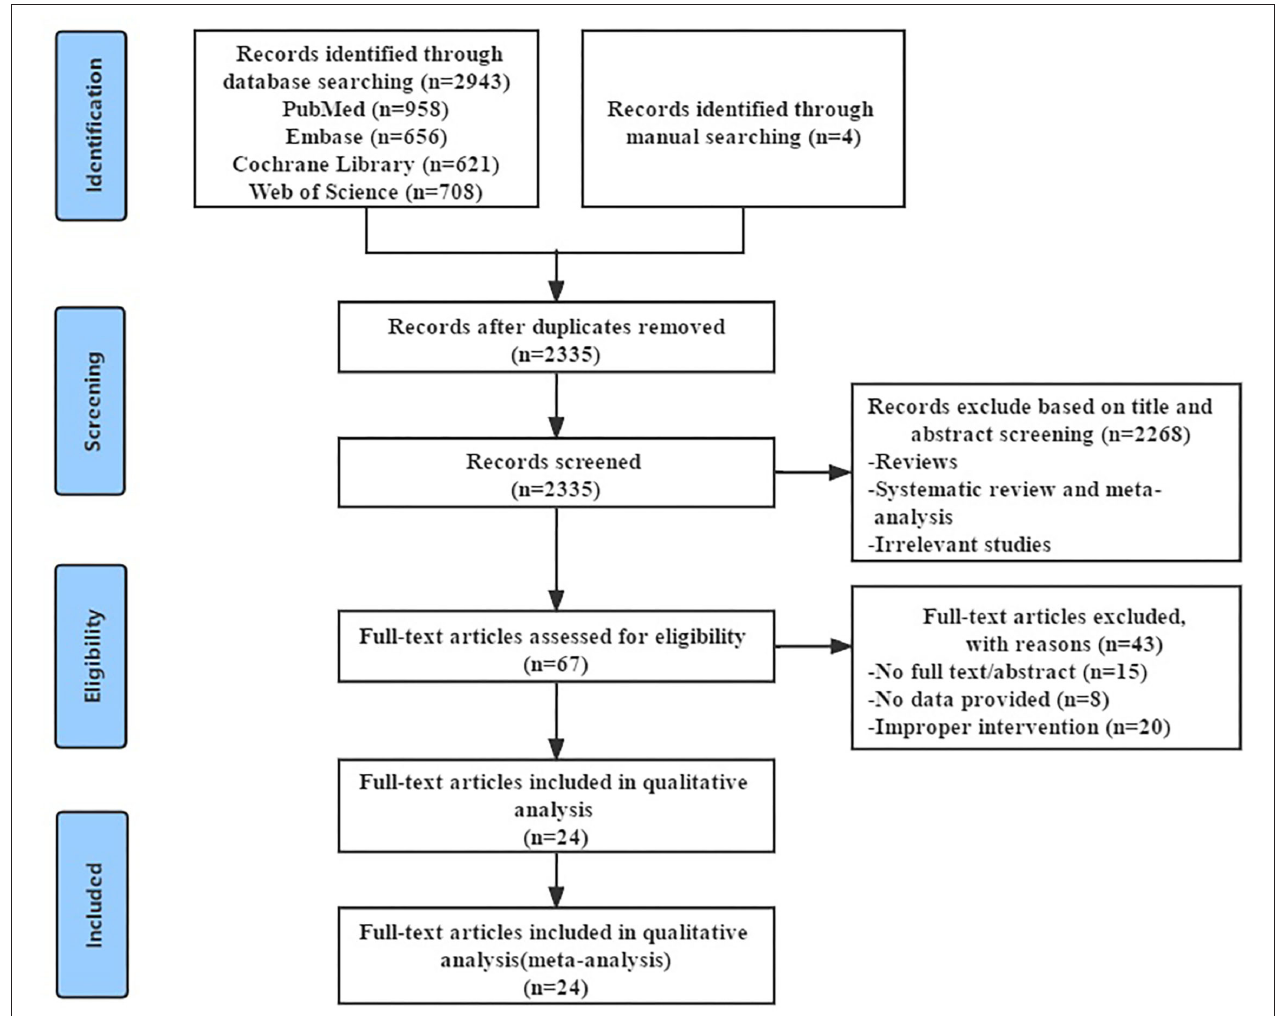
FIGURE 1 | Flowchart of meta-analysis search and selection